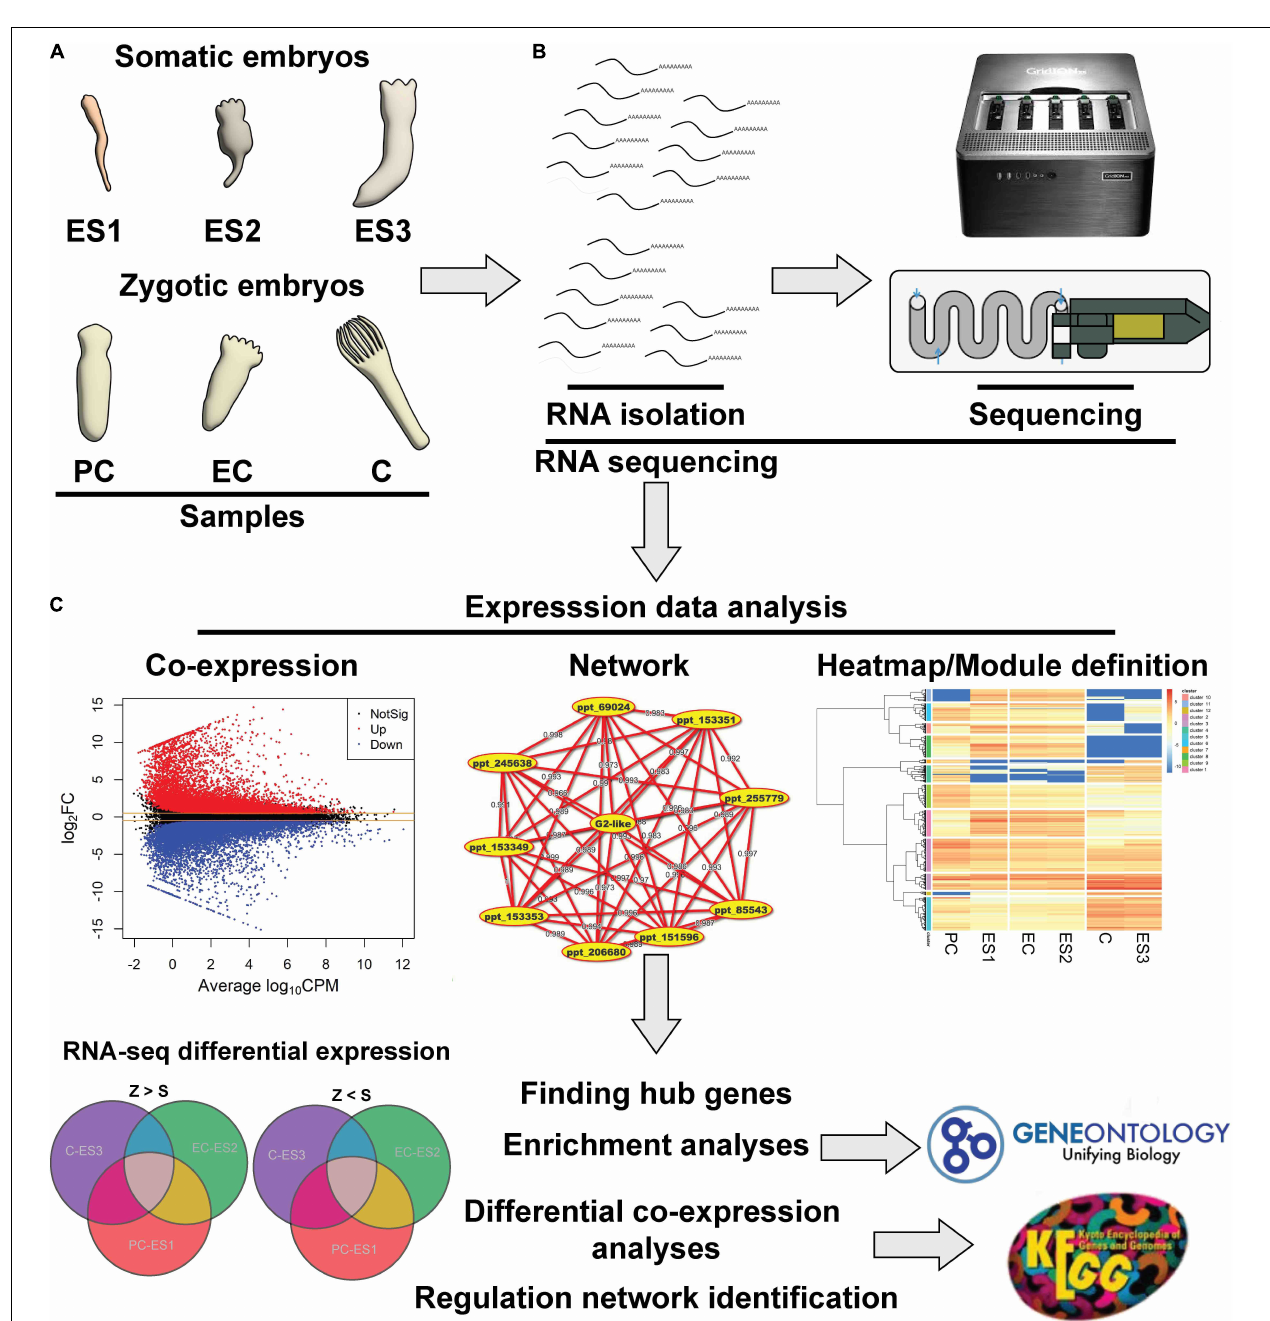
FIGURE 1 | Experimental design. (A) Schematic representation of comparative developing stages of somatic: early-stage translucent (ES1), pre-cotyledonary opaque (ES2), and cotyledonary (ES3) and zygotic embryos: pre-cotyledonary (PC), early cotyledonary (EC) and cotyledonary (C). (B) Scheme of RNA extracted from samples and subsequent NGS-sequencing. (C) Differential expression analysis using bioinformatics